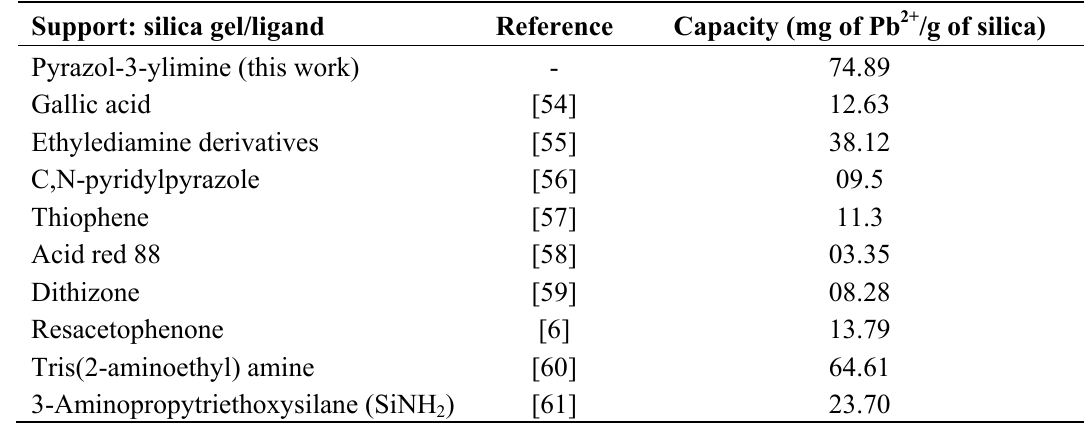
Table 3. Comparison of SiNP with other reported sorbents for Pb(II)